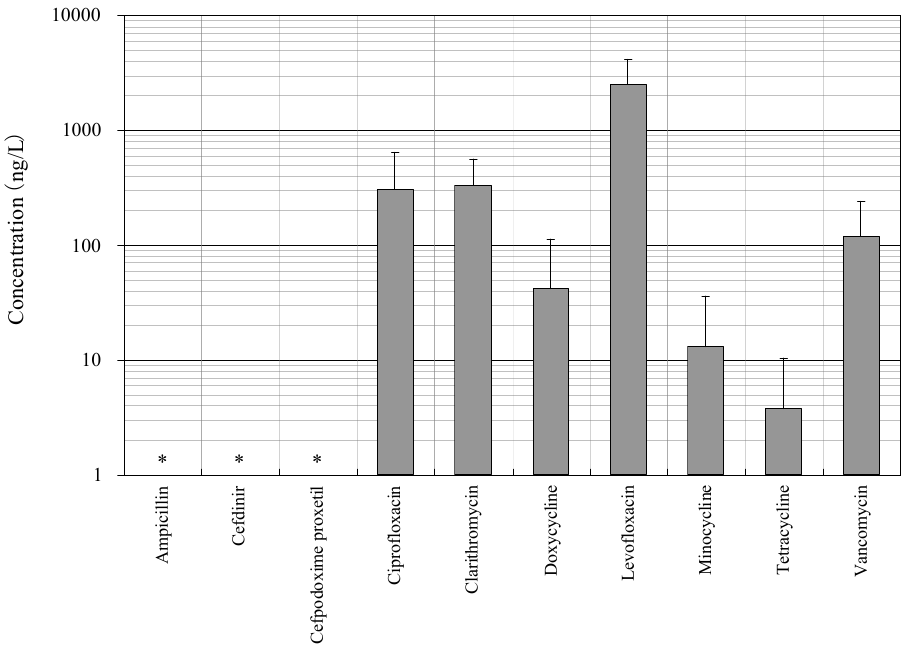
Figure 1. Measured concentrations of targeted antimicrobials in STP influents (*: Not detected).